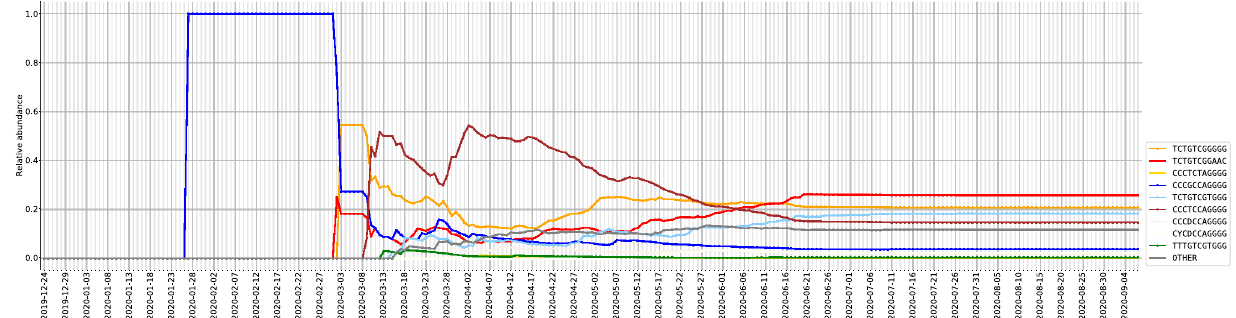
Figure 4. Temporal analysis show the relative abundance of different viral subtypes in India over a period of time. The lines become horizontal after a point of time because sequences sampled after that time haven’t been submitted as of the retrieval date. The two light colored ISMs CCCDCCA GGG G and CYCDCCA GGG G were found to be abundant in Supplementary Fig. region from 5 to 12 kbs with very less masked entropy (i.e., entropy < 0.2; see Fig. 1). Another gene named surface glycoprotein in a conserved region represent only one site with high uncertainty. Furthermore, genes coding for